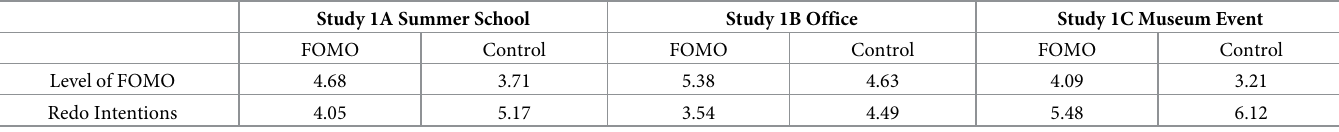
Table 2. Summary of mean ratings for experienced FOMO and intentions to redo the current